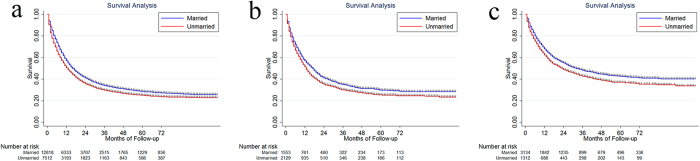
The survival difference between married and unmarried patients in Caucasian (a), African-American (b) and Asian (c).